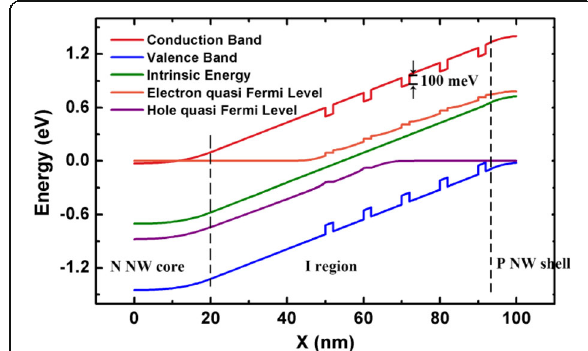
Fig. 2 The illuminated energy band diagram of the NW/QD hybrid solar cells